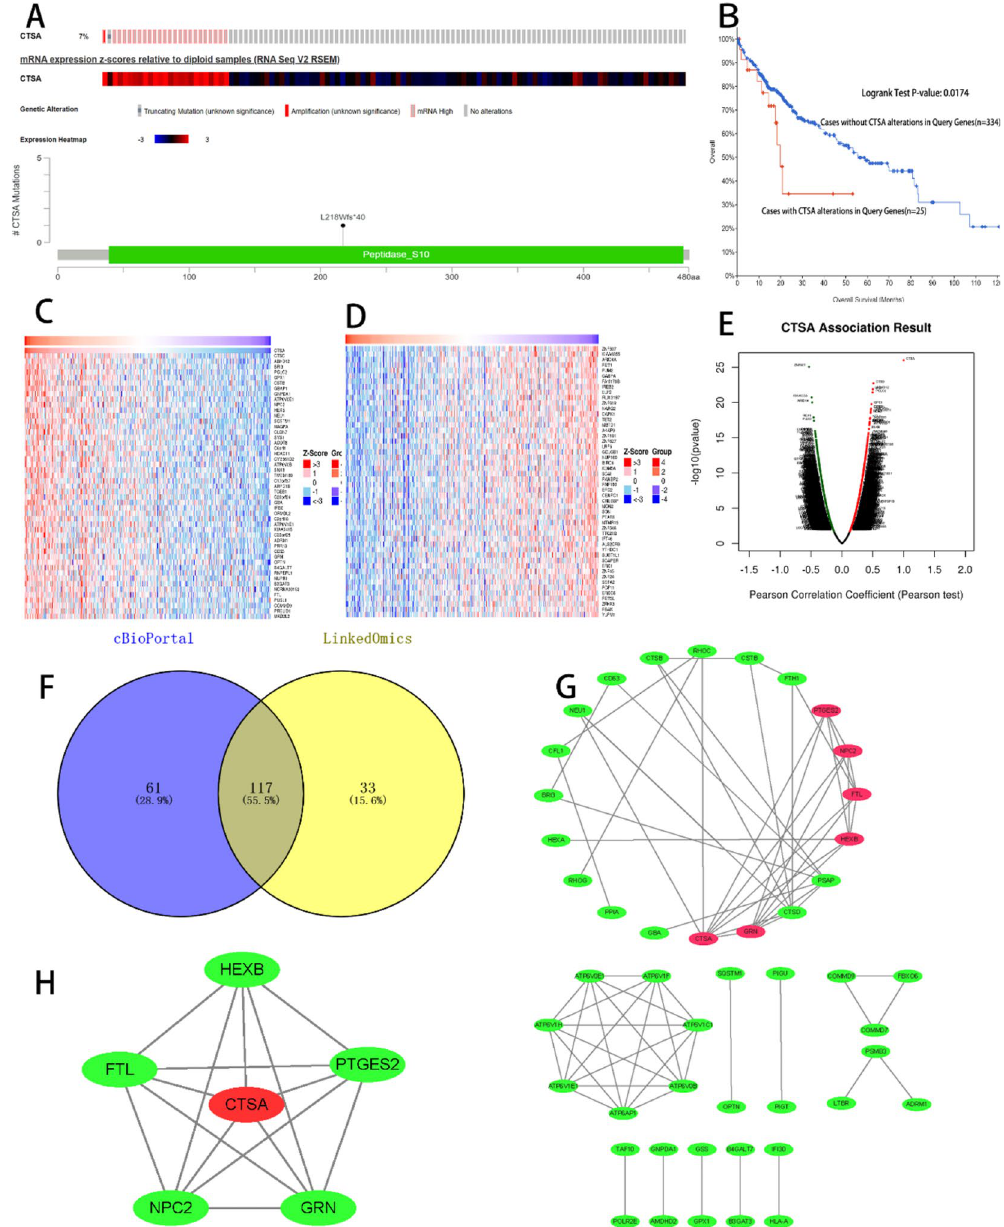
Figure 4. Alteration analyzed in RNA-sequencing data and identification of CTSA co-expressed genes. ( A ) The alteration and Expression Heatmap of CTSA in a cohort of 359 HCC patients (TCGA, Firehose Legacy) from the cBioPortal database. 7% queried genes in this cohort exhibited alteration. One mutational hotspot, L218Wfs*40/frameshift deletion mutation was labeled. ( B ) the Kaplan–Meier curve shows that the OS percentage of HCC patients with CTSA alterations (n = 25) is poorer than without CTSA alterations. ( C – E ) CTSA correlated target genes analysis in the linkedomics database. ( C ) The top 50 genes that are positively correlated to CTSA. ( D ) The top 50 genes that are negatively correlated to CTSA. ( E ) Volcano chart display CTSA Positively/Negatively Correlated Significant Genes. ( F ) 117 overlapping genes with Spearman’s Correlation greater than 0.35 obtained in the cBioportal database and the LinkedOmics database were screened as co-expressed genes of CTSA. ( G ) The 117 co-expressed genes of CTSA were used to construct the PPI networks with a confidence score of > 0.900 (highest confidence). ( H ) The PPI network showed that the FTL, GRN, NPC2, HEXB, and PTGES2 protein can interact with